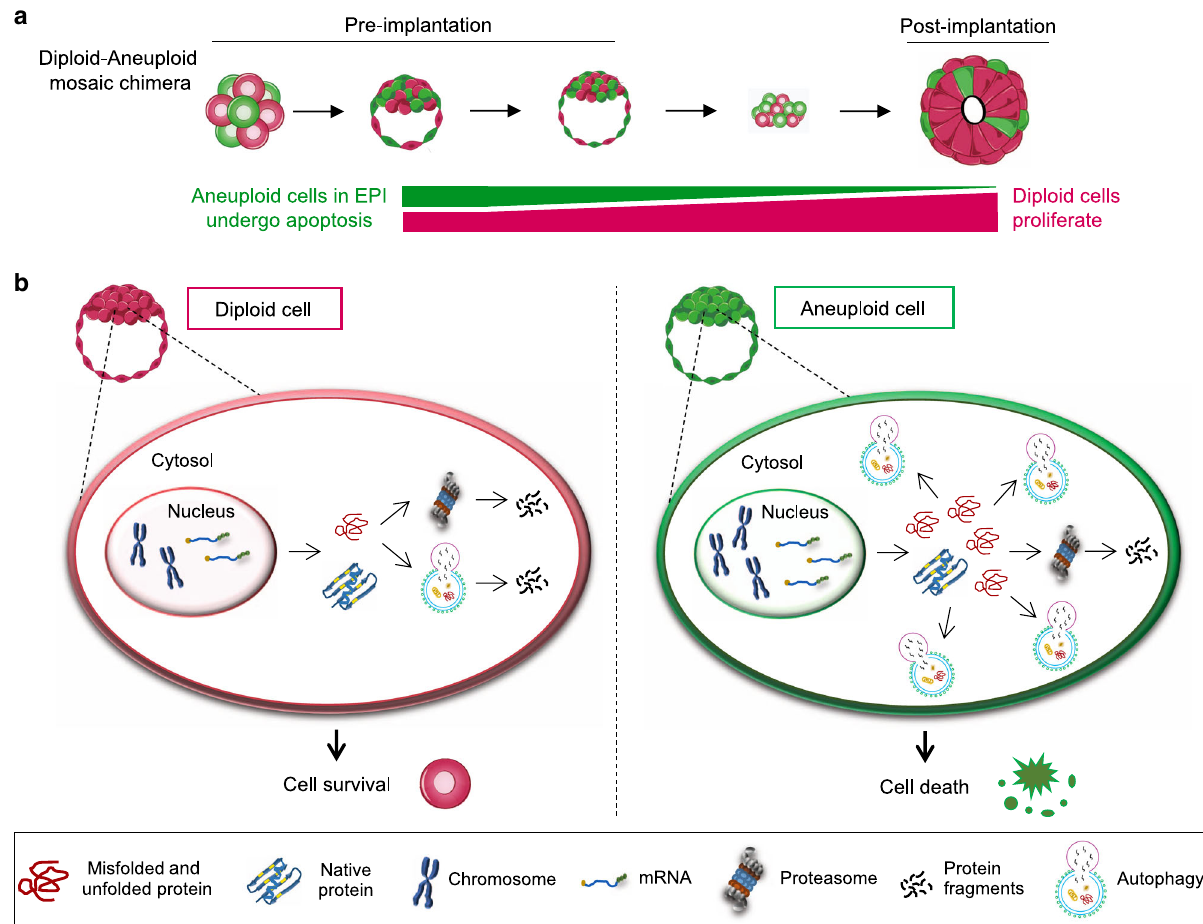
Fig. 8 Model for the elimination of aneuploid cells in the mouse embryo. a Aneuploid cells generated at the four- to eight-cell stage are progressively depleted from the epiblast of the mosaic embryo from the early blastocyst stage to the early post-implantation via apoptosis. Diploid cells in the same embryo over-proliferate to compensate for the reduction in overall epiblast cell number thereby allowing for successful development. b In a normal (diploid) cell, cellular protein quality control mechanisms, involving the proteasome machinery and autophagy, degrade misfolded/unfolded proteins to prevent cytotoxicity and promote healthy cell survival 26 . We hypothesise that in an aneuploid cell in the epiblast, gene aberrations are translated into protein aberrations. Chronic protein misfolding after several mitotic divisions upregulates autophagy to an extent where instead of protecting the cell, it mediates cell death. This prevents the aneuploid cell from continuing further in the development of the